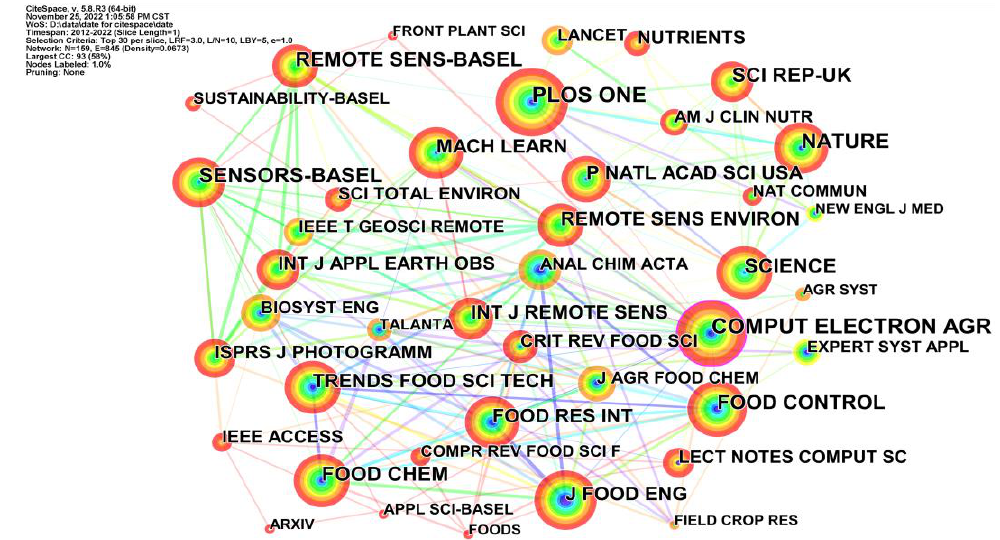
Figure 8. The journal co-citation network of AI related publications.